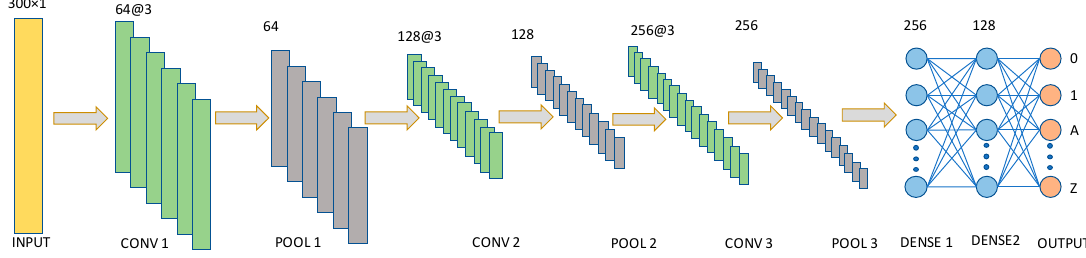
Figure 7. Proposed convolutional neural network (CNN) model. The model has three convolutions, three max-pooling and 2 dense layers.